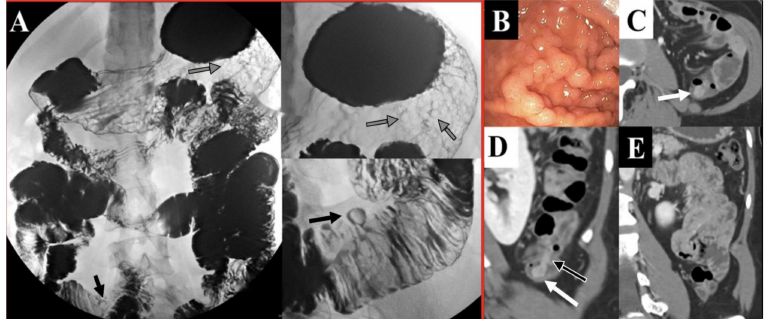
Figure 7. A 23-year-old female with known PJS. ( Panel A ) Upper GI series with barium contrast. Multiple filling defects throughout the stomach (gray arrows, upper figure) and jejunum (black arrows, lower figure) are characteristic of PJS. Presence of these polyps was confirmed by upper endoscopy ( Panel B ). ( Panels C and D ) Contrast-enhanced CT scan with enhancing polypoid lesions (white arrows) in the descending colon (axial section in panel C , coronal images in panels D and E ). One of the polyps appears to have a thin stalk (black arrow with white border).